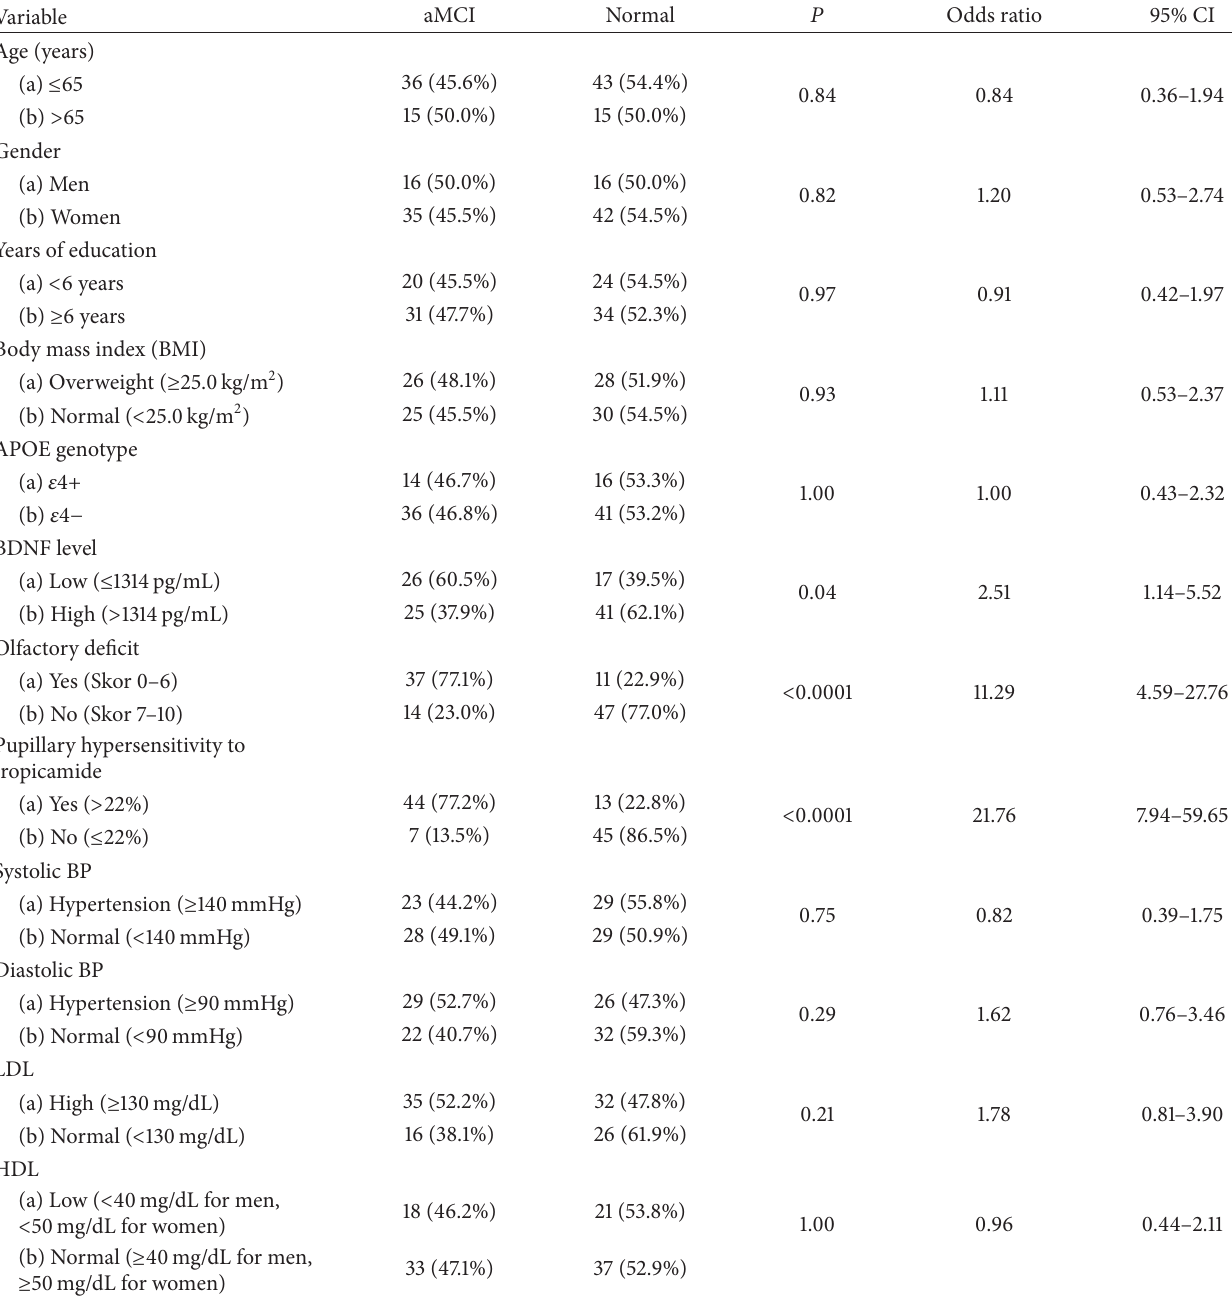
Table 1: Demographic and clinical status in elderly with aMCI and normal cognition.